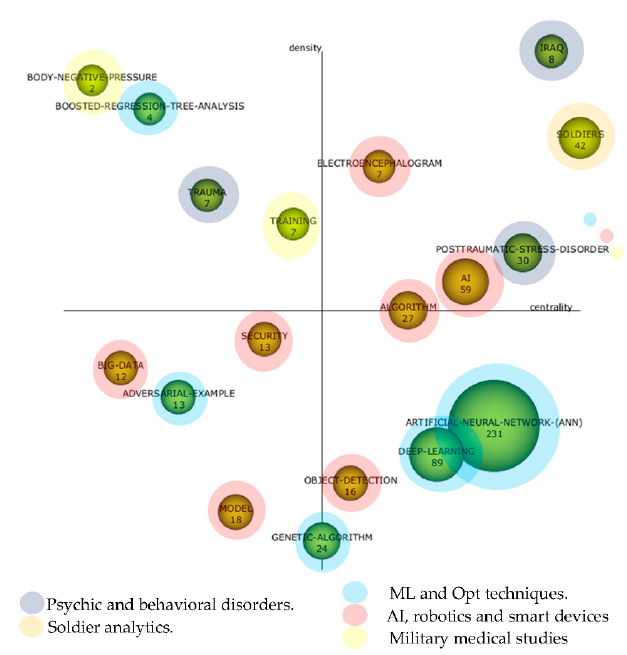
Figure 9. Strategy map; Categories from 2016.